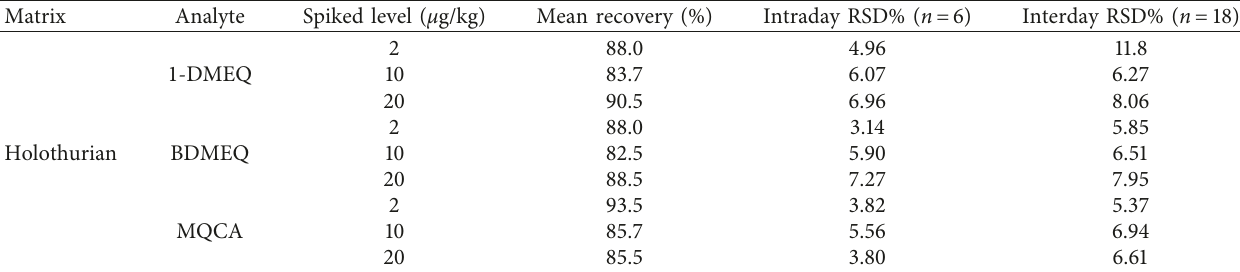
Table 4: The accuracy and precision for the analysis of MQCA, 1-DMEQ, and BDMEQ residues in holothurian. Matrix Analyte